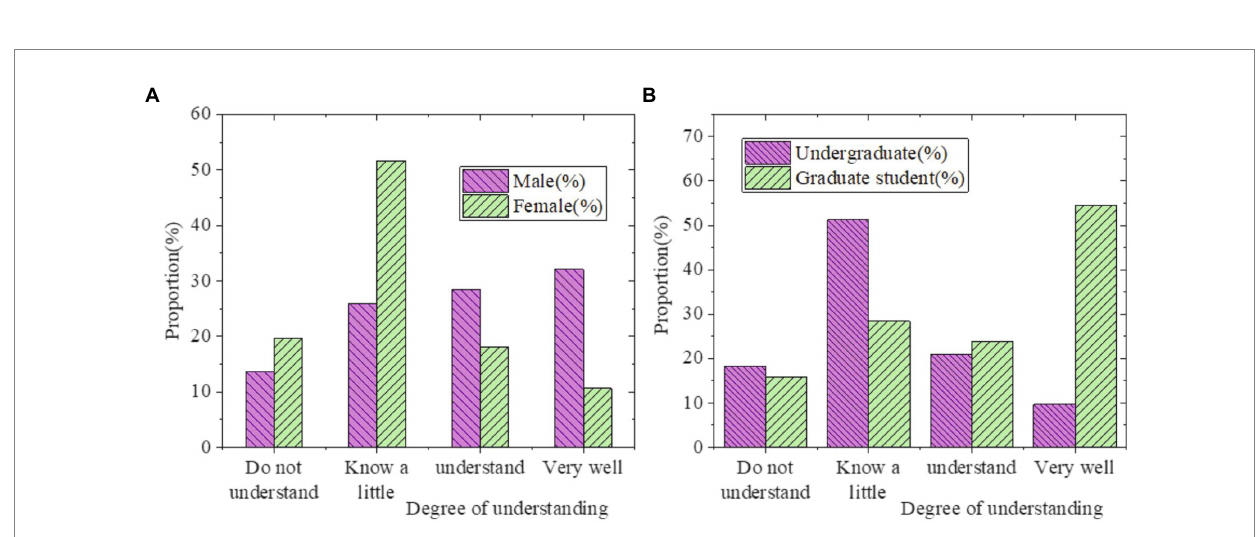
FIGURE 4 University students’ understanding of Guozhuang dance ( A : Statistics by gender; B : Statistics by educational